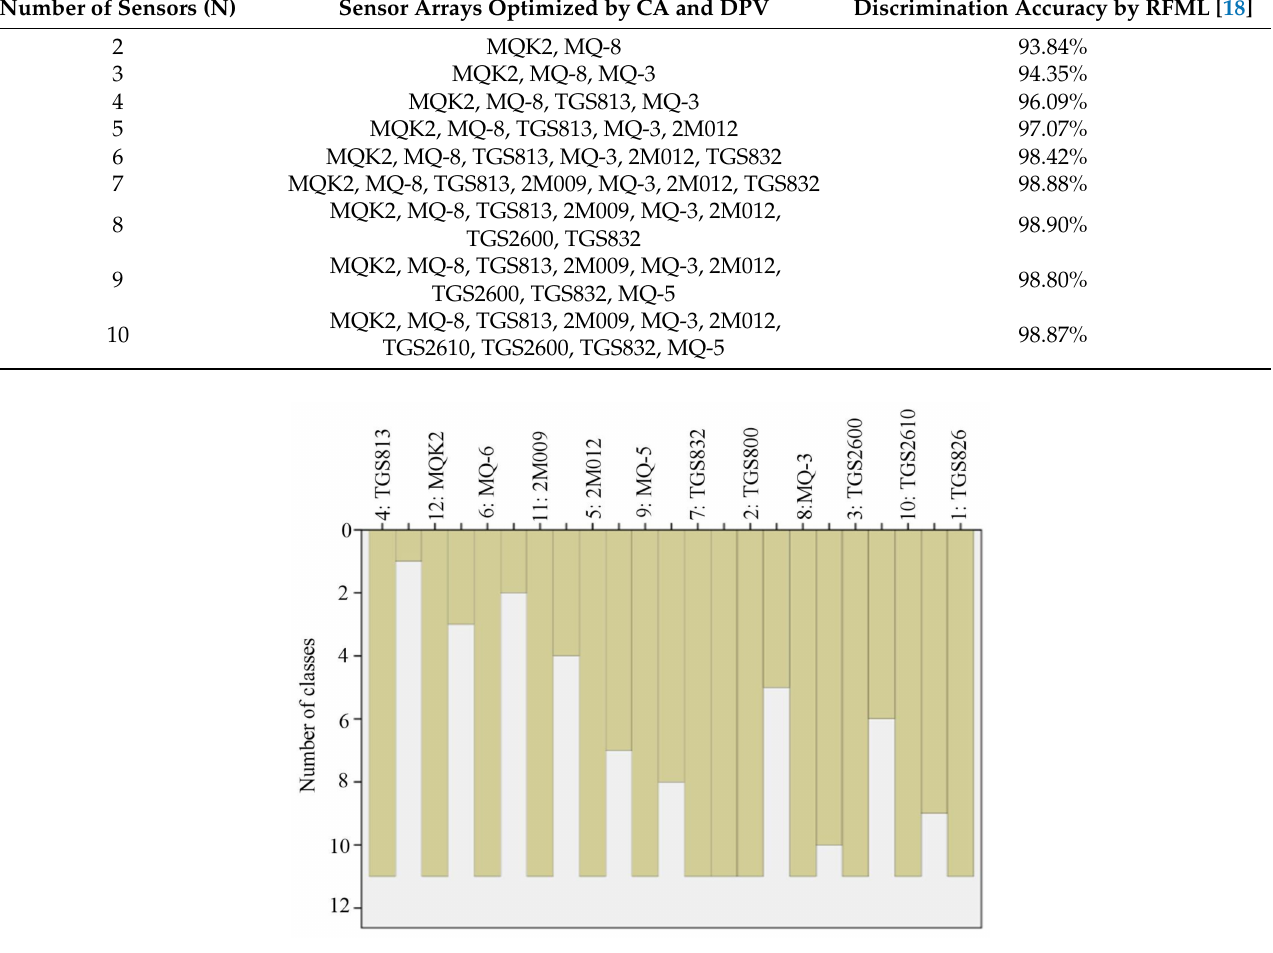
Figure 8. Icicle figure of clustering sensors’ response average value (3 kinds of fried green